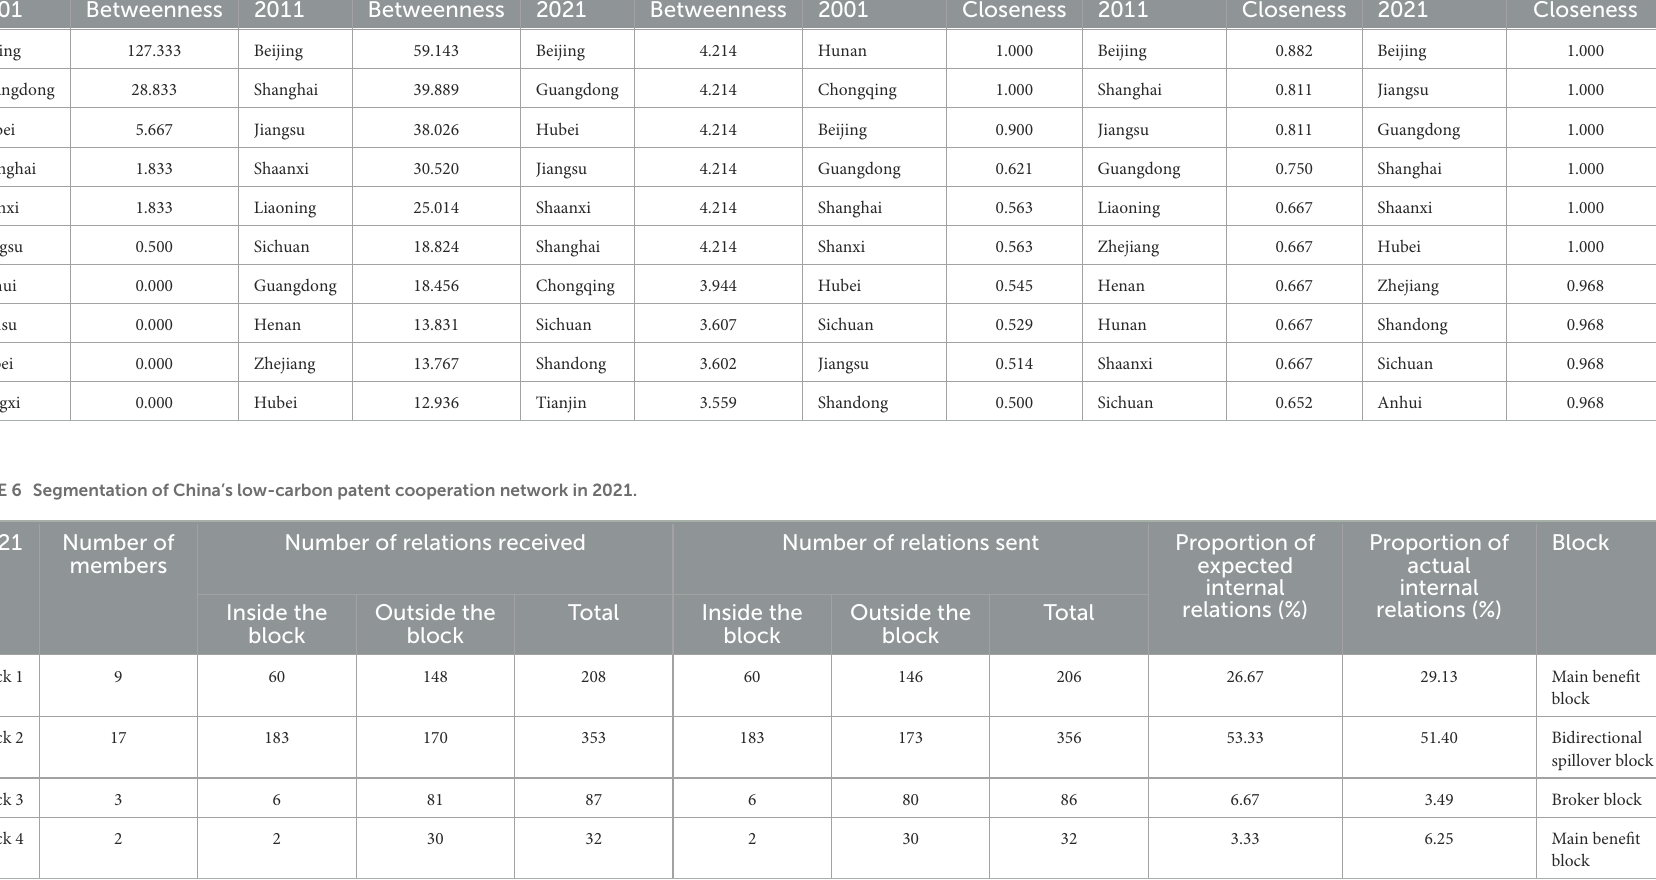
TABLE 5 Top 10 provinces/municipalities in China’s low-carbon cooperation network in terms of betweenness and closeness centrality in 2001–2021. 2001